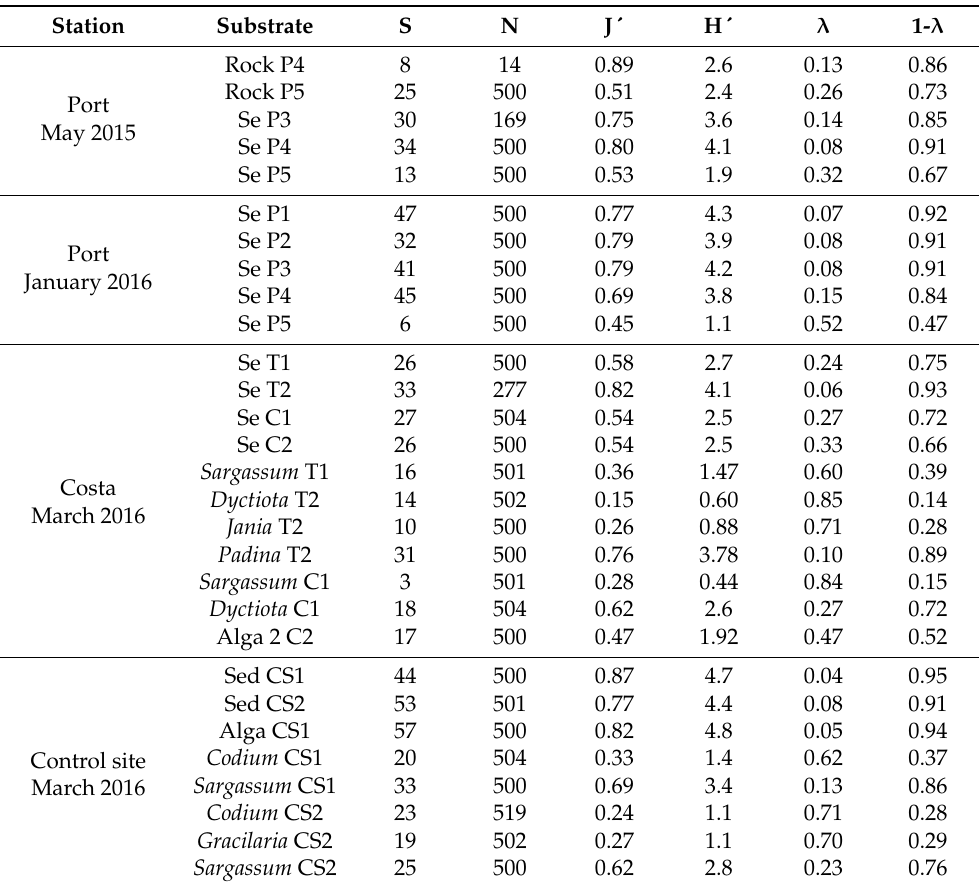
Table 5. Index values describing the structure of benthic diatoms at sampling stations in Santa Rosalia and Control Site. Species richness (S), sample size (N), Pielou’s equitability (J (cid:48) ), Shannon’s diversity (H (cid:48) ), Simpson (cid:48) s dominance ( λ ), Simpson’s diversity (1- λ ). R = rock; Se =